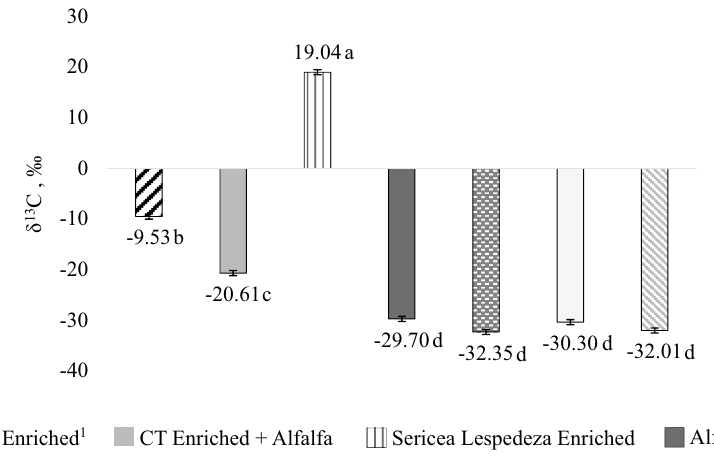
Figure 1. Isotopic composition of substrates used on in vitro incubations of Trial 2 determined with isotope ratio mass spectrometry. 1 CT enriched: condensed tannins enriched with 13 C–CO 2 . 2 CT not enriched: condensed tannins not enriched with 13 C–CO 2 . Means with different letters are significantly different by Tukey test ( P < 0.05). Bars refer to the standard